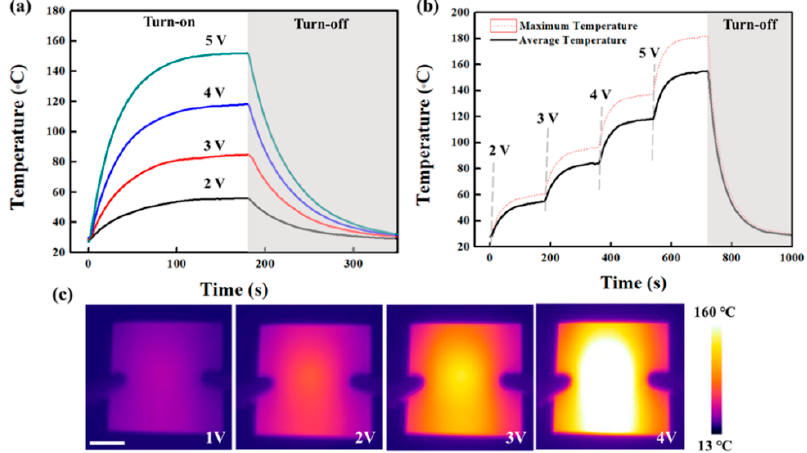
Figure 6. ( a ) Time-dependent temperature of thin Ag NWs network-based film heaters (20 × 20 mm 2 ) under operation at different voltages. ( b ) Temperature evolution of thin Ag NWs network-based film heaters at stepwise voltage rise from 2 to 5 V. ( c ) Temperature profiled of 20 × 20 mm 2 electrodes, measured using an IR camera (scalebar = 6.5 mm).